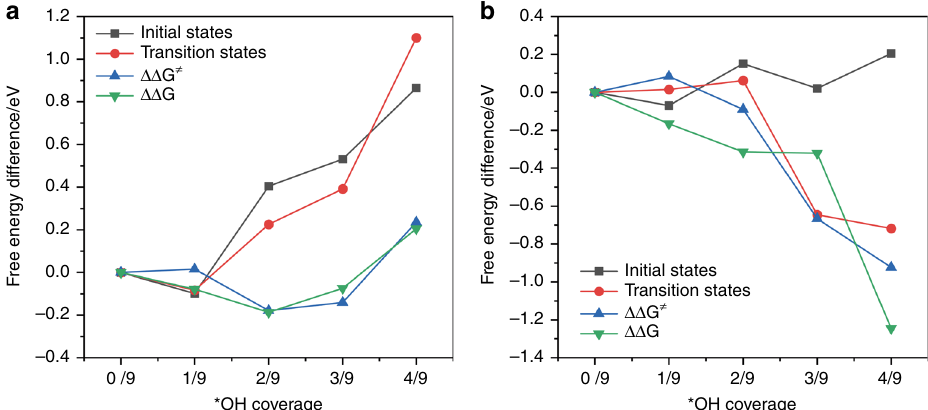
Fig. 5 Free energy diagram. a *CO dimerization. b *CO hydrogenation. The binding free energies for initial states and transition states at different *OH coverage are calculated with reference to a Cu slab with speci fi c numbers of *OH, gas phase CO, H 2 , and liquid H 2 O molecules. The potential is − 0.5 V SHE (i.e., equivalent to − 0.9 V RHE ). ΔΔ G ( ΔΔ G ≠ ) is de fi ned as the reaction-free energy (free energy barrier) at certain *OH coverage referenced to the value obtained at zero *OH coverage (see “ Methods ” section for